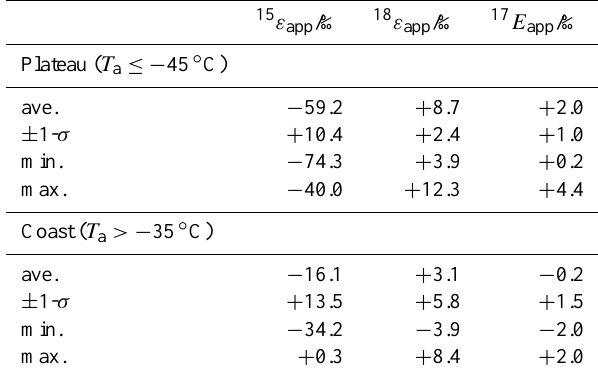
Table 3. Apparent fractionation constants n ε ( n = 15 , 17 , 18 for δ 15 N, 1 17 O and δ 18 O, respectively) in East Antarctica: average, standard deviation, minimum and maximum values. For the plateau we have also used all previously published data (see in Table